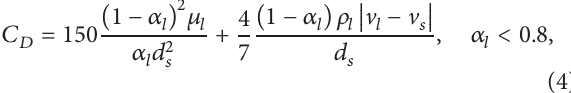
caused by the external force, and ∇𝑝 refers to the turbulent pressure gradient.